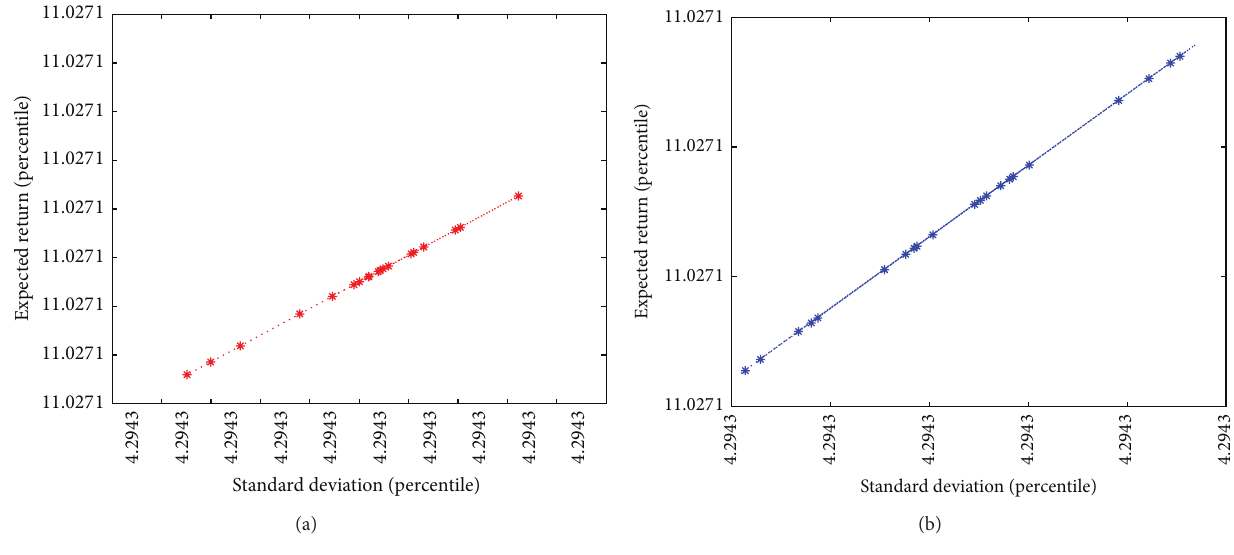
Figure 1: Efficient frontier obtained by Models 1 and 3 for Example 1.